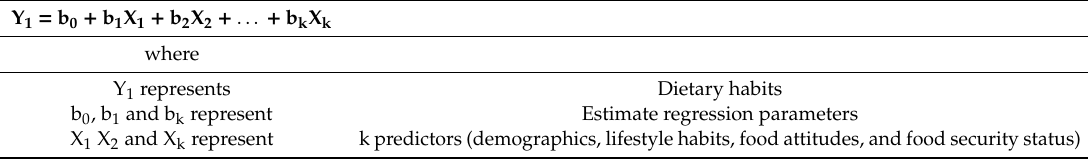
Table 1. Model for regression